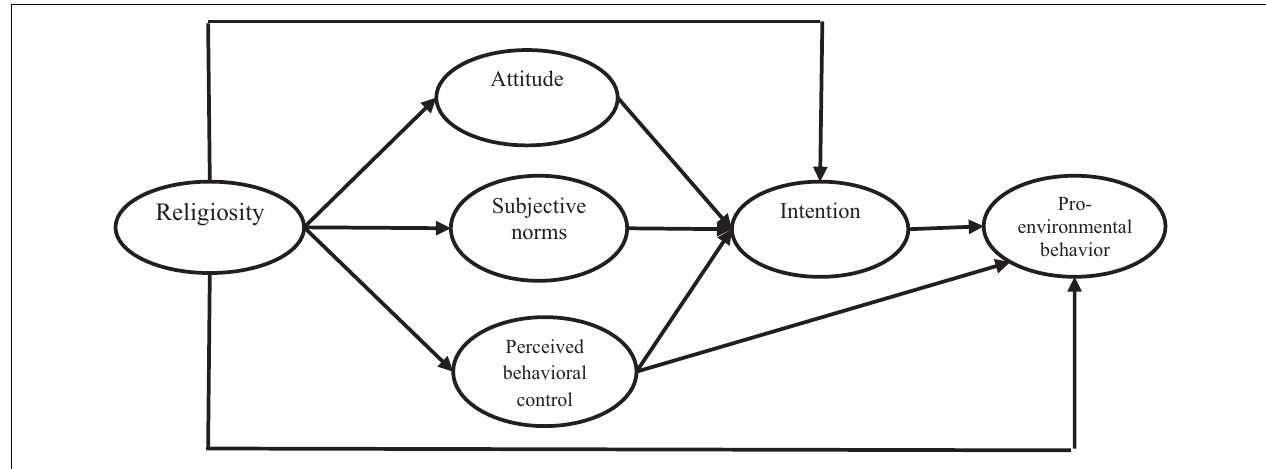
FIGURE 1 | Theoretical research